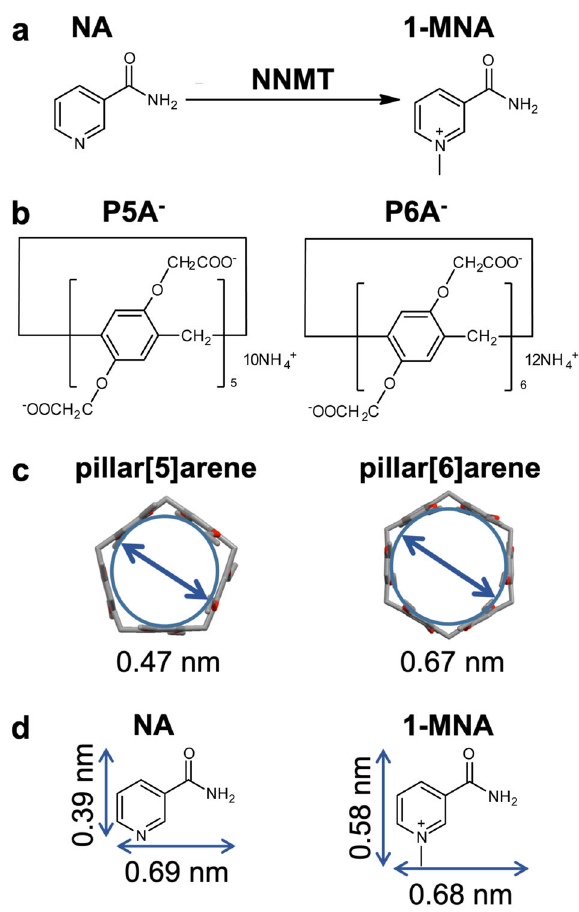
Fig. 1 Chemical structures of molecules and complexes investigated in this work. a NNMT catalyses the methylation of nicotinamide (NA) to produce 1-methylnicotinamide (1-MNA). b Structures of P5A and P6A. c Diameter of the inscribed circle within the cavity. d Molecular sizes of nicotinamide and